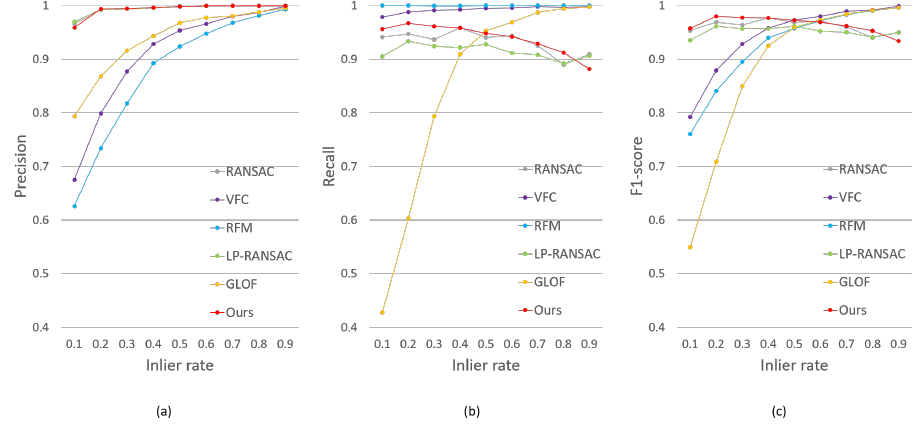
Figure 8. Matching accuracy performance comparison of the considered six methods for the “Univer- sity Campus” dataset. ( a ) For precision. ( b ) For recall. ( c ) For F1-score. Table 2. Average F1-score comparison for the “Small Village” dataset.